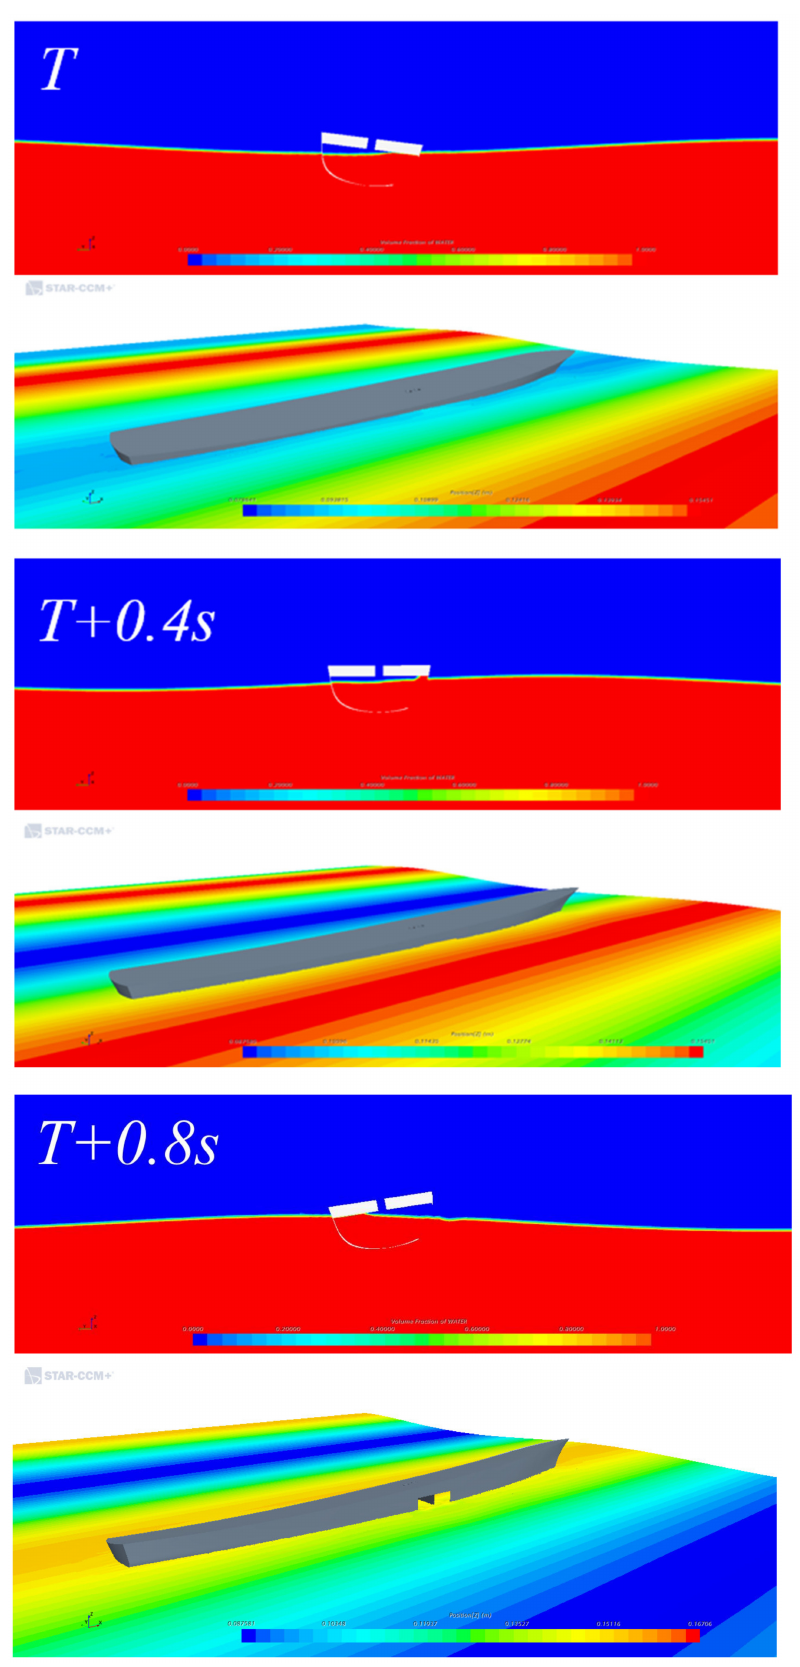
Figure 7. Plot at the free surface with a wave period of 1.47 s and a wave height of 0.118